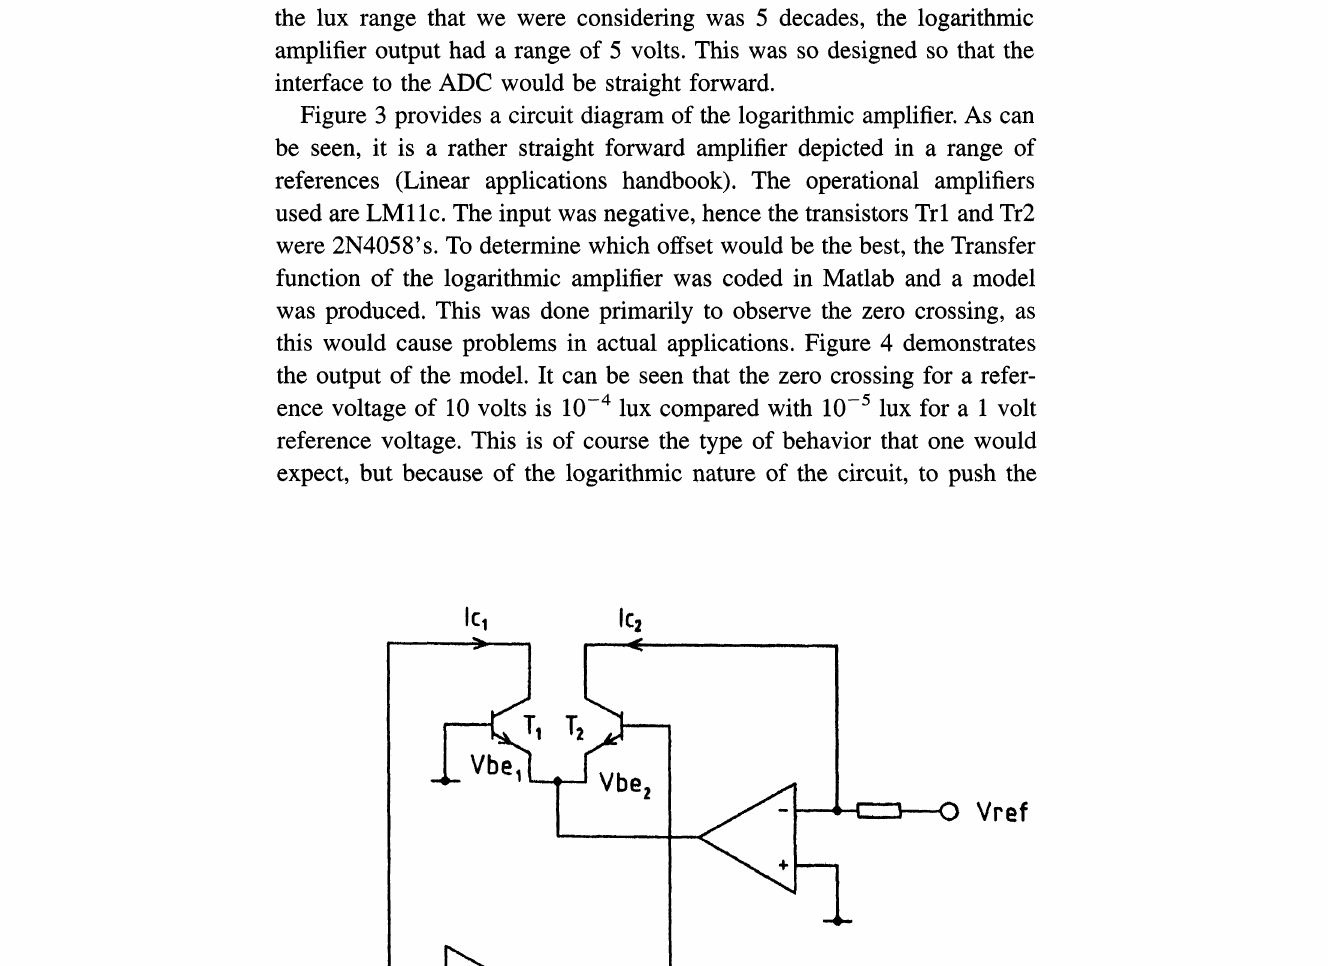
FIGURE 3 Circuit Diagram of Logarithmic